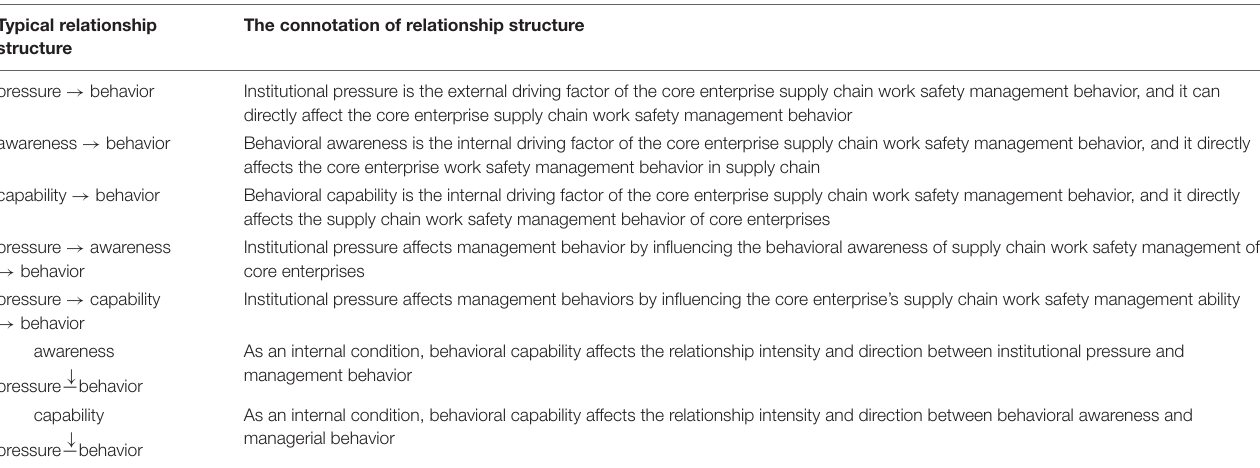
TABLE 4 | Typical relationship structure of the main